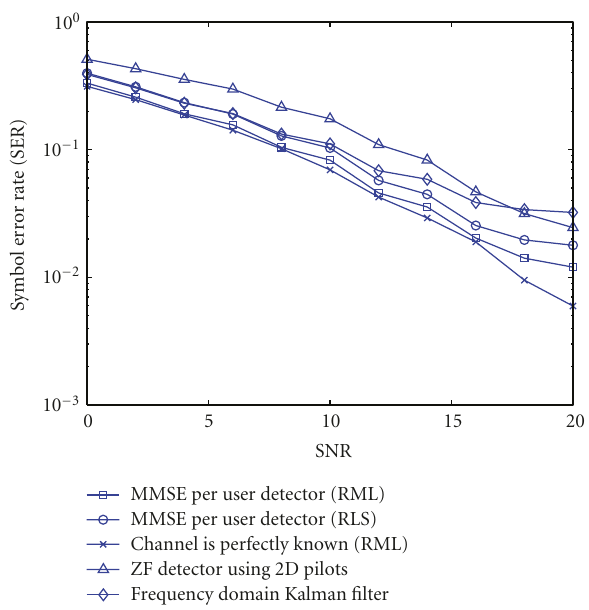
Figure 3: Symbol-error rate (SER) for di ff erent channel-tracking methods in urban